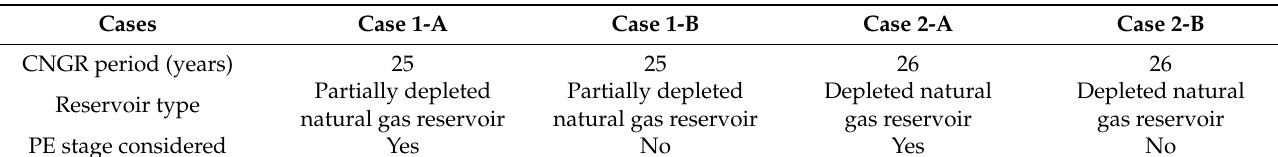
Table 2. Description of the four cases used to show the effects of residual CH 4 content and CO 2 -plume establishment stage on the performance metrics.